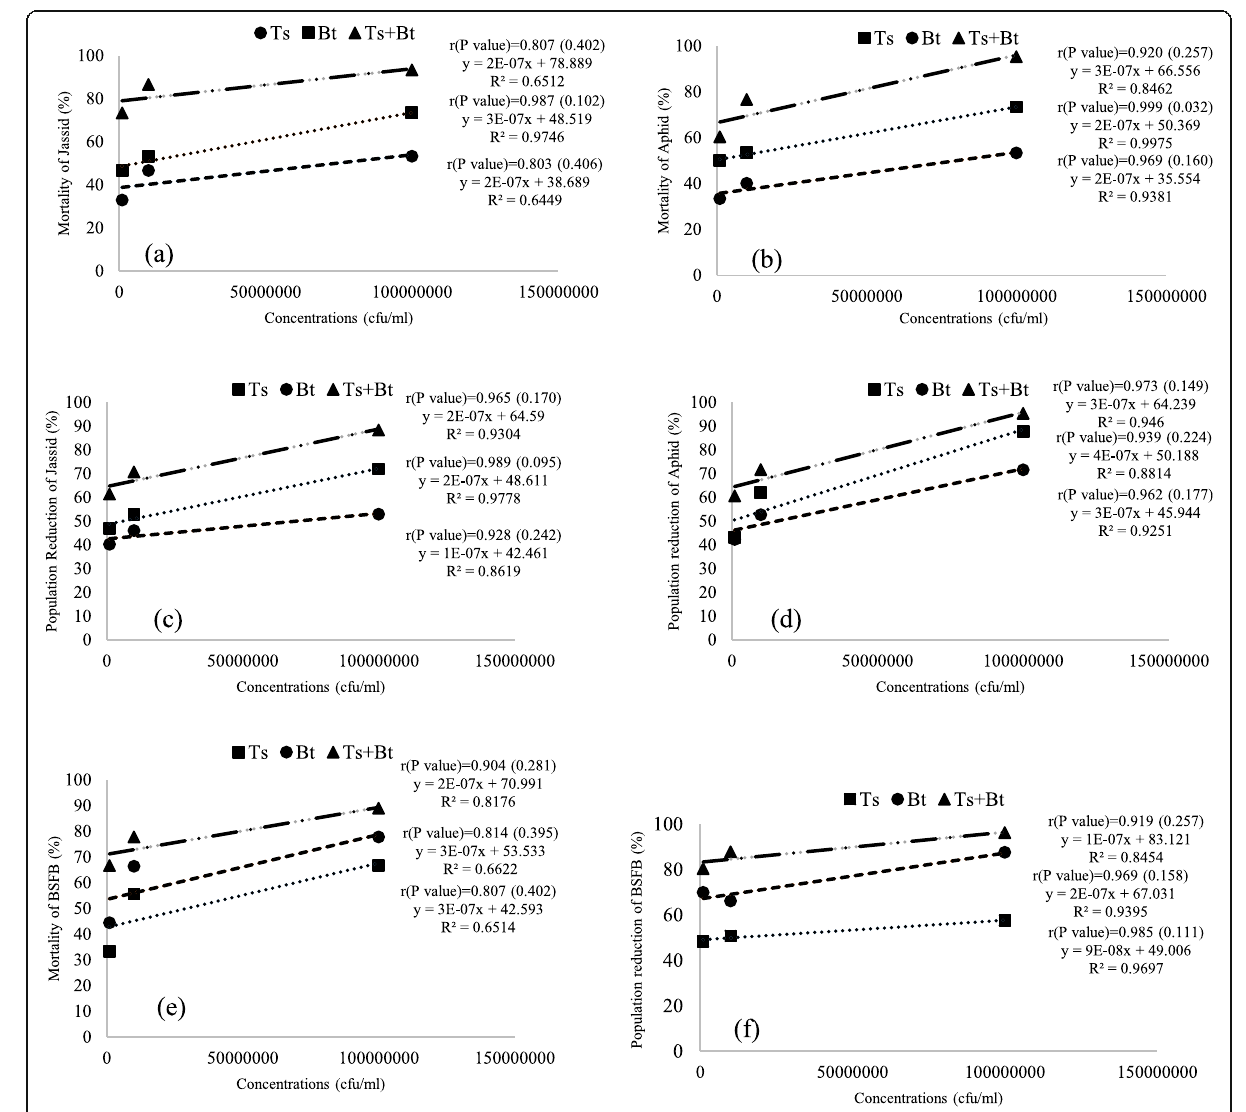
Fig. 1 The correlation coefficient values and scatter diagram showed a positive correlation with mean percent mortality of target insect pests in laboratory as well as under field conditions ( R 2 : coefficient of determination), ( Ŷ : dose-dependent percentage mortality of target pests) ( X : densities of aphid, jassid, and brinjal shoot and fruit